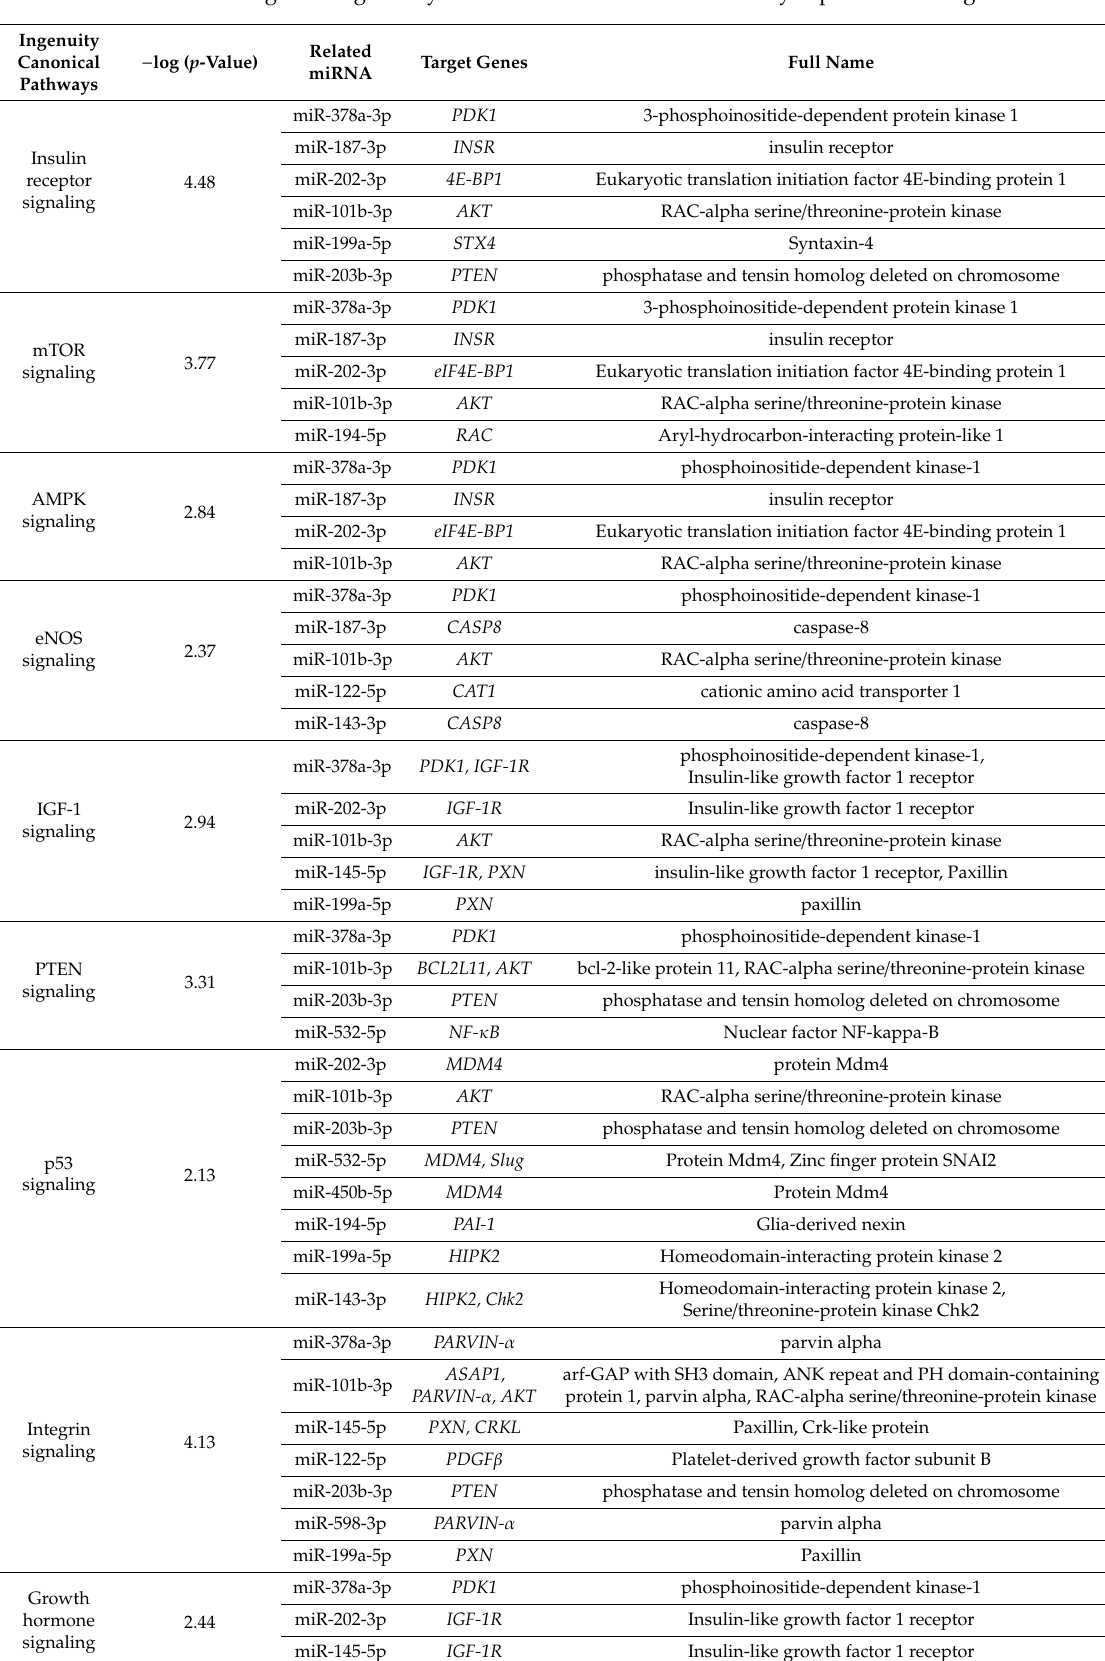
Table 2. IPA of genes targeted by 19 miRNAs that were di ff erentially expressed with age. Ingenuity − log ( p Canonical Pathways